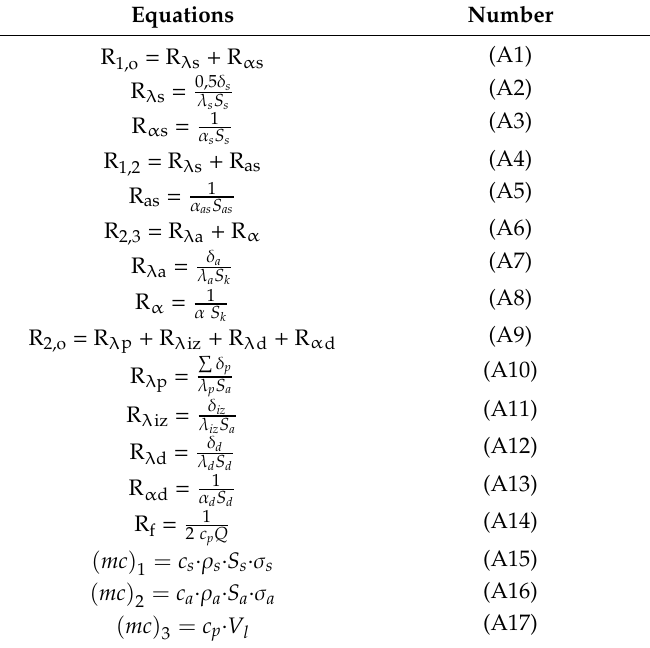
Table A2. List of equations used for thermal resistances and heat capacities